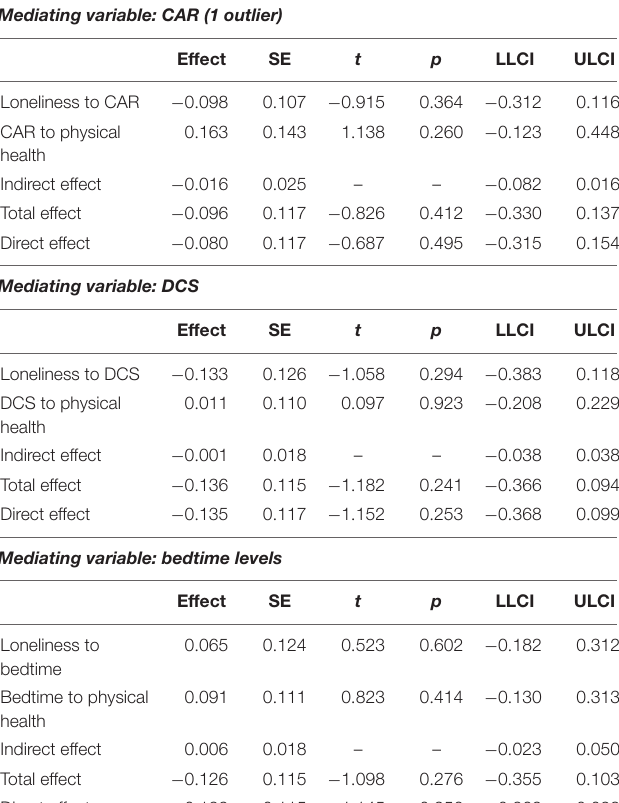
TABLE 6 | Adjusted mediation models of the relationship between loneliness as predictor and physical health as dependent variables via cortisol indexes (CAR, DCS, and